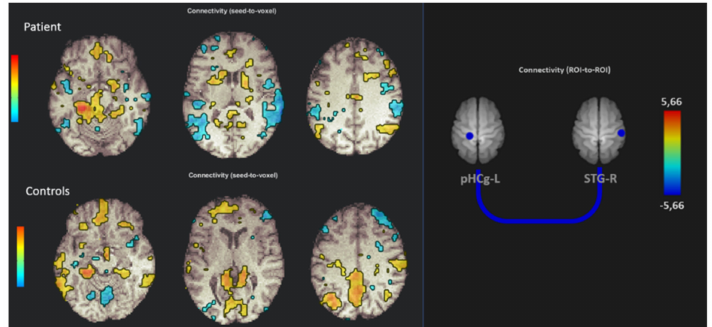
Figure 3. On the left, the resting-state fMRI seed-to-voxel analysis using the left parahippocampal gyrus as the seed in the patient and HC. On the right, seed-to-seed analysis showing significant hypoconnectivity between the left parahippocampal gyrus (pHCg-L) and the right superior temporal gyrus